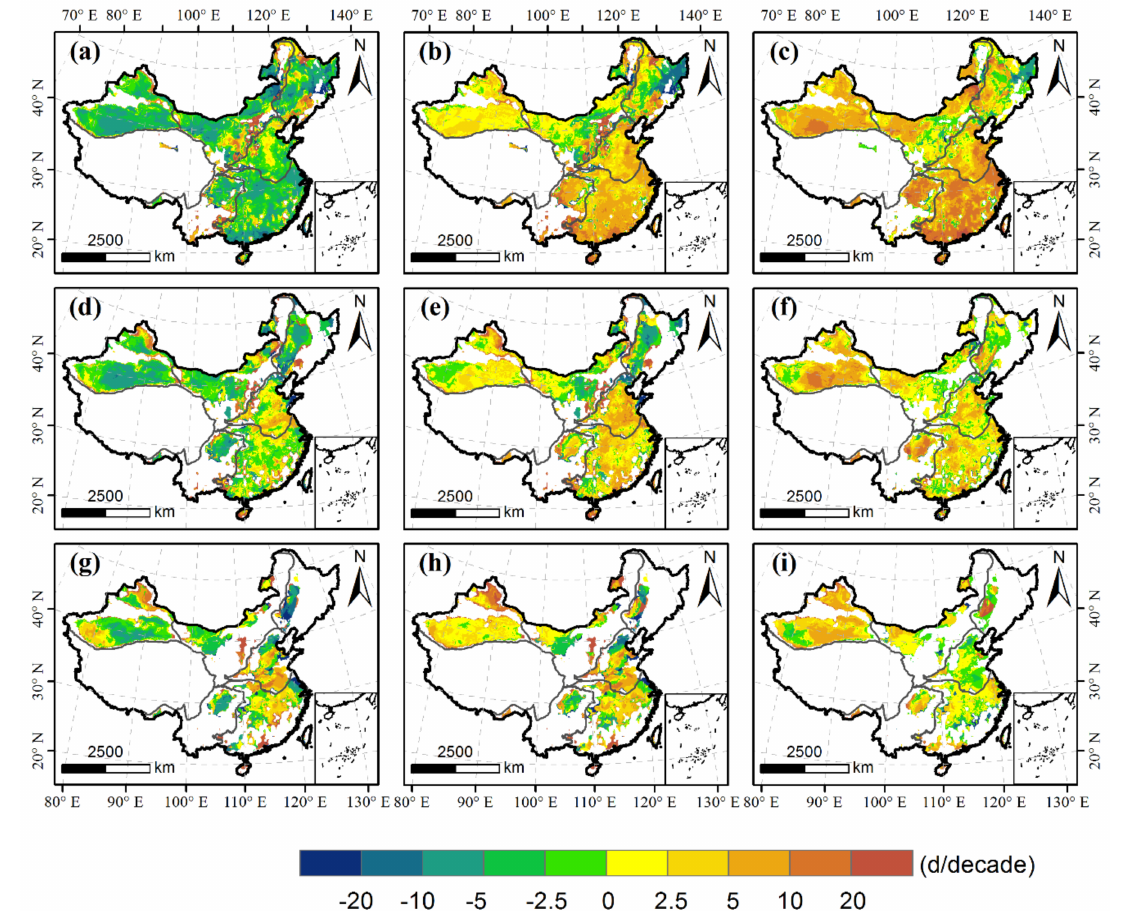
Figure 9. Trend of heatwave onset, termination, and duration at different levels for years from 1979 to 2018. First ( a , d , g ), second ( b , e , h ), and third ( c , f , i ) columns were onset, termination, and duration, respectively. First ( a – c ), second ( d – f ), and third ( g – i ) rows are light heatwave, moderate heatwave, and severe heatwave,